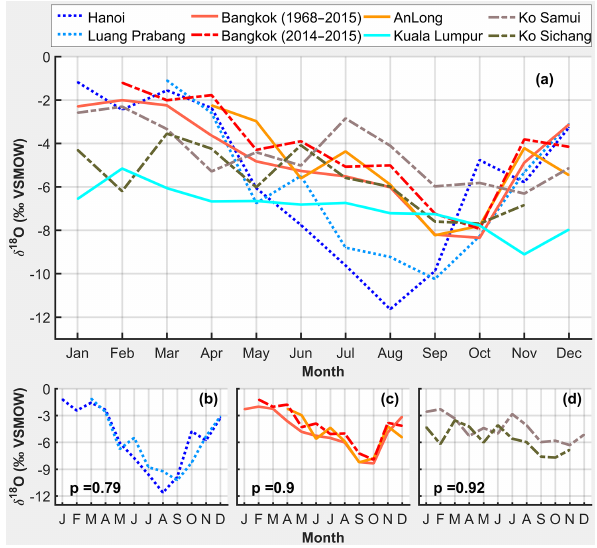
Figure 9. Seasonal monthly mean δ 18 O values for An Long and GNIP data from the Indochinese Peninsula. The data are grouped according to similar variability tested with the Levene test. The p values given in (b) – (d) are the test statistics. High values indicate similar variance. The time series of Bangkok is plotted for short- term (2014–2015) and long-term (1968–2015)